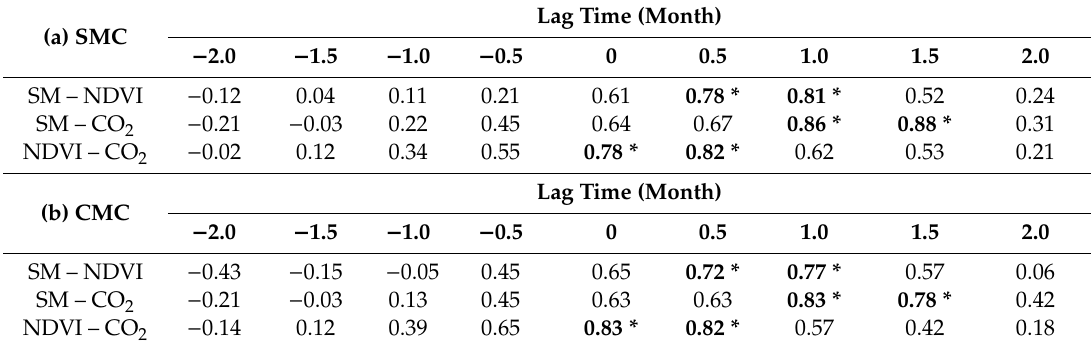
Table 6. Lag correlation for study